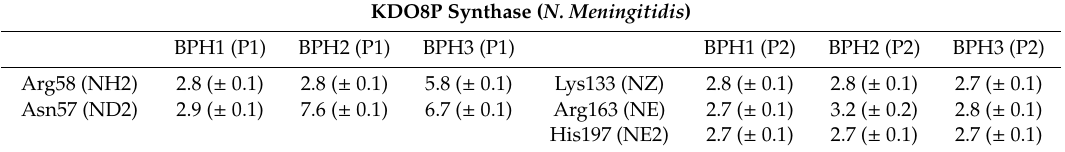
Table 1. Distances (in Å) for the phosphate groups from MD simulations. (P1) represents the P atom derived from the PEP moiety, while (P2) represents the P atom from the A5P moiety (see Figure S3 for details).